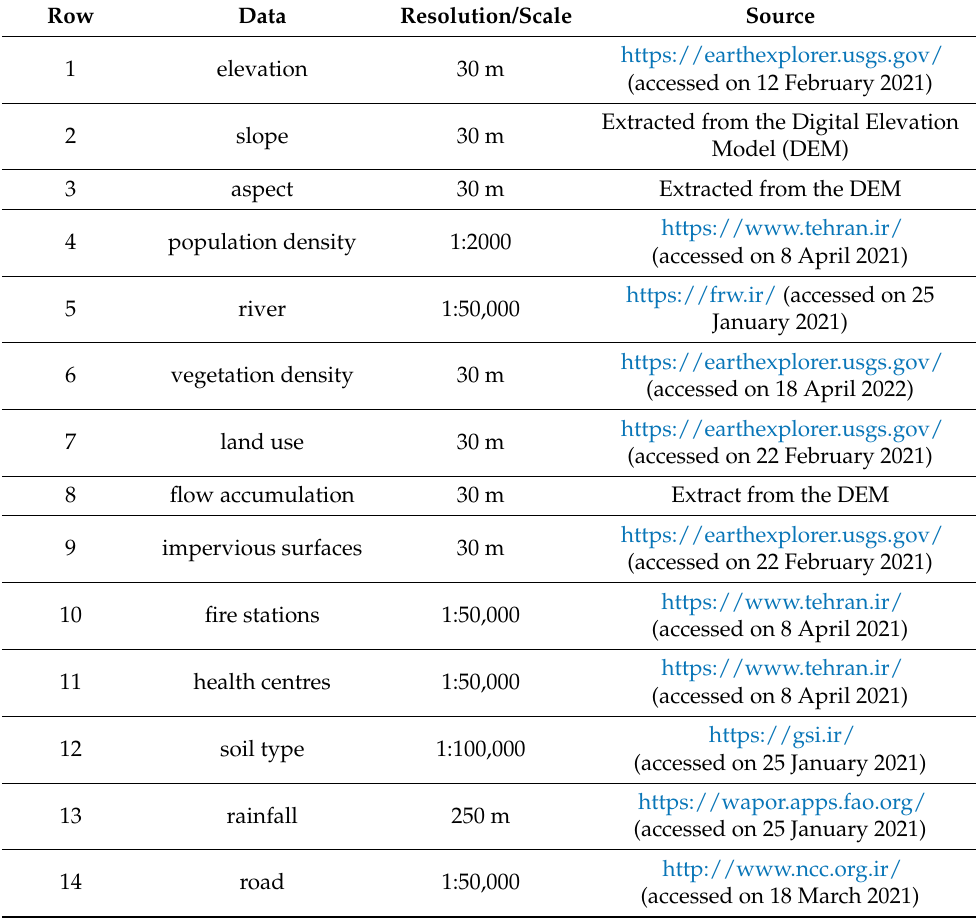
Table 2. Characteristics of the used